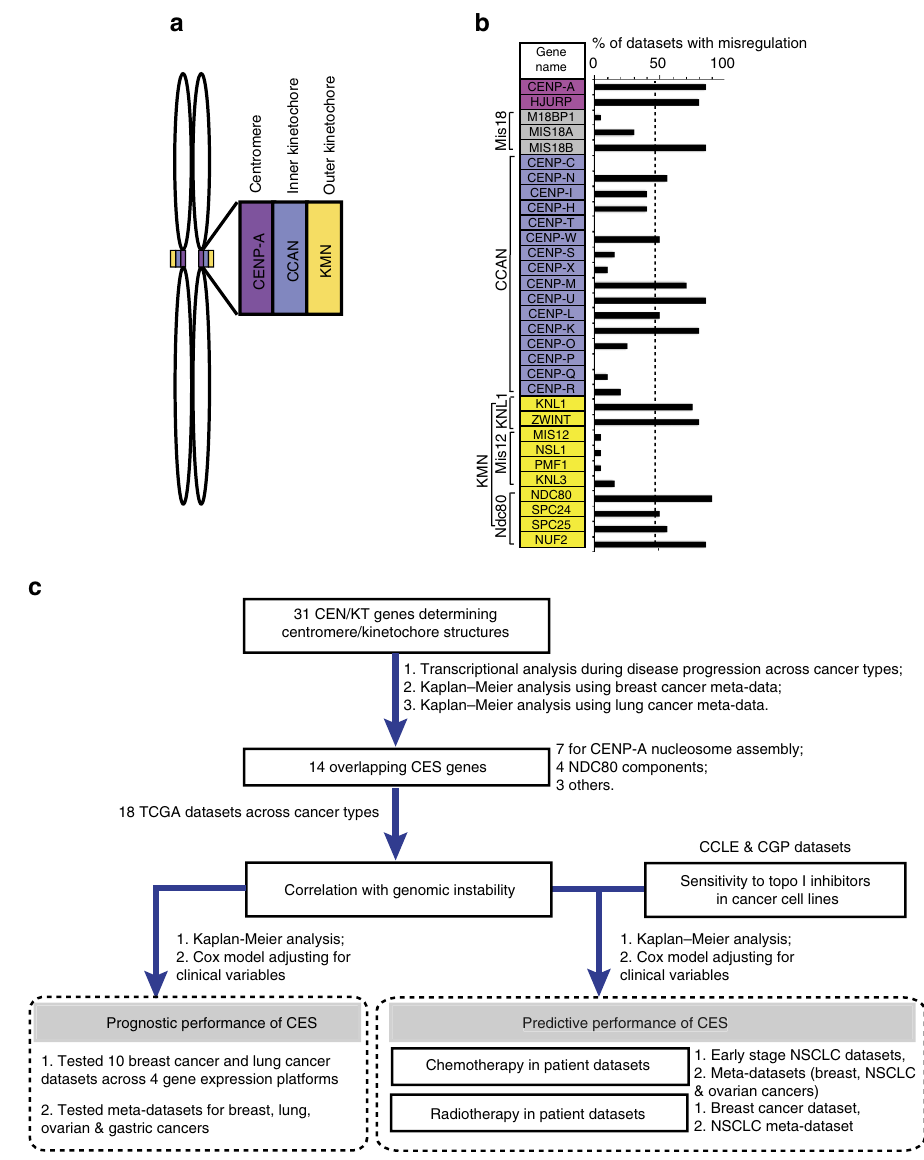
Figure 1 | Summary of the approach and transcriptional misregulation of CEN/KTgenes across cancer types. ( a ) Schematic overview of the centromere and kinetochore on replicated mitotic sister chromatids. CENP-A nucleosomes (purple) are the structural base for centromeric chromatin and kinetochore formation, and the CCAN network (blue) in the inner-kinetochore connects CENP-A chromatin to the KMN network (yellow) at the outer kinetochore. ( b ) The list of 31 CEN/KT genes. Cells are highlighted with colours matching (A) except for HJURP (purple) and Mis18 complex members (gray), which transiently localize to centromeres for new CENP-A assembly. The Affymetrix probes for CENP-P did not pass the specificity qualifier filter, and CENP-P was indicated with no value and subsequently removed from all other analysis. The graph to the right shows that 15 out of 31 CEN/KTgenes are misexpressed (fold change Z 2-fold, FDR-adjusted P o 0.05) in 4 50% of data sets for nine cancer types, specifically breast, cervical, head and neck (including nasopharyngeal), colon, gastric, brain and CNS, liver, lung, and pancreatic cancers, compared with their corresponding normal tissues, or between late- and early-stage lesions. Also see Supplementary Data 1. ( c ) A flow chart showing the overall research ductal carcinoma in situ (DCIS) (Supplementary Fig. 1B,I), corresponding normal tissues, and in late- versus early-stage suggesting that defective CEN/KT gene expression is not simply a tumours, revealed that 15 out of 31 CEN/KT genes were result of over-proliferation. Furthermore, we performed significantly misregulated (all upregulated; false discovery rate expression correlation network analysis using large TCGA data (FDR)-adjusted P o 0.05, at least twofold difference, and in at sets and found that CEN/KT gene expression levels across cancer least 50% (as empirical prevalence cutoff) data sets examined; types, and among individuals within the same type, can differ Fig. 1b; Supplementary Data 1). Their significant overexpression significantly (Supplementary Fig. 2; Supplementary Note 1). in individual data sets was further confirmed by a permutation To understand the potential role of CEN/KT genes in cancer test, where we computed the probability of getting CEN/KT gene progression, we analysed 13 Affymetrix gene expression micro- overexpression that is higher than the observed fold changes after array data sets from nine cancer types (Supplementary Data 1). data randomization (Supplementary Table 2). These results Comparing the expression levels in tumours with those in indicate that defective CEN/KT gene regulation is present among